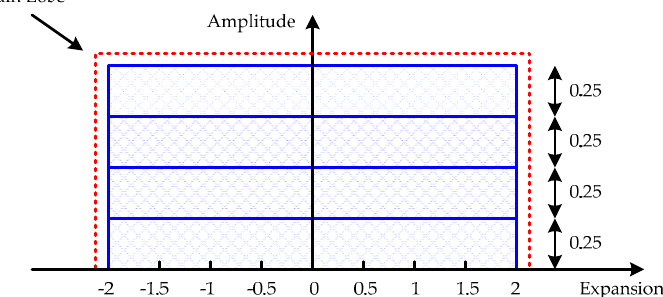
Figure 3. Sketch map of envelope with equal section lengths. The rectangles with blue lines are sketch maps of the envelope of four sections after MPSM.